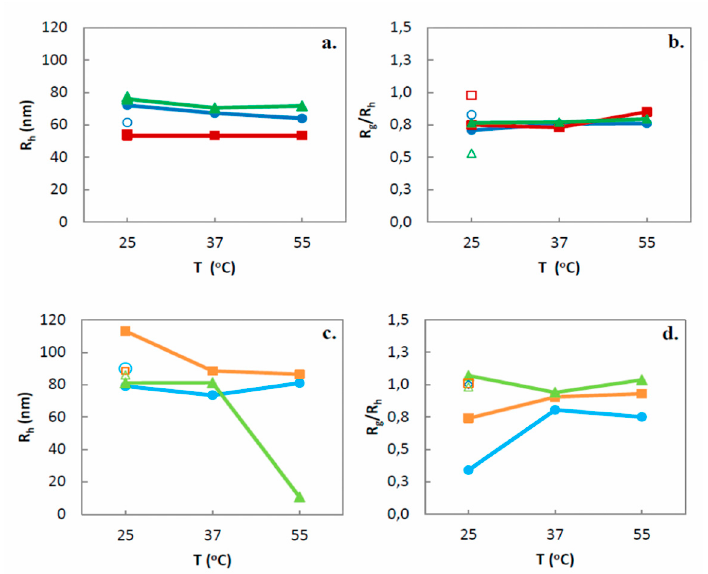
Figure 5. Hydrodynamic radius ( R h , nm) of a. GMO and c. PHYT nanosystems, as well as R g /R h ratio of b. GMO and d. PHYT nanosystems depending on the temperature ( ● : Lipid:PDMAEMA-b-PLMA of b. GMO and d. PHYT nanosystems depending on the temperature (